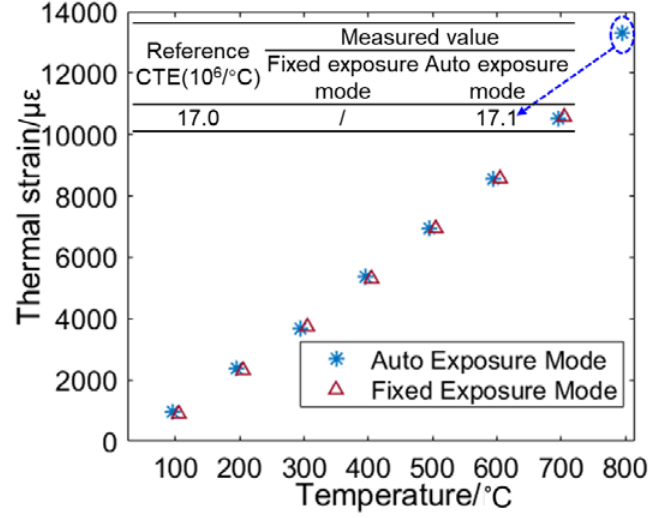
Figure 12. Thermal strain of the specimen at different temperatures.